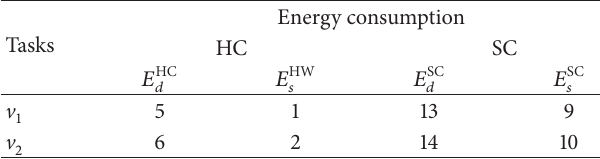
Table 1: Energy consumption of embedded system with 2